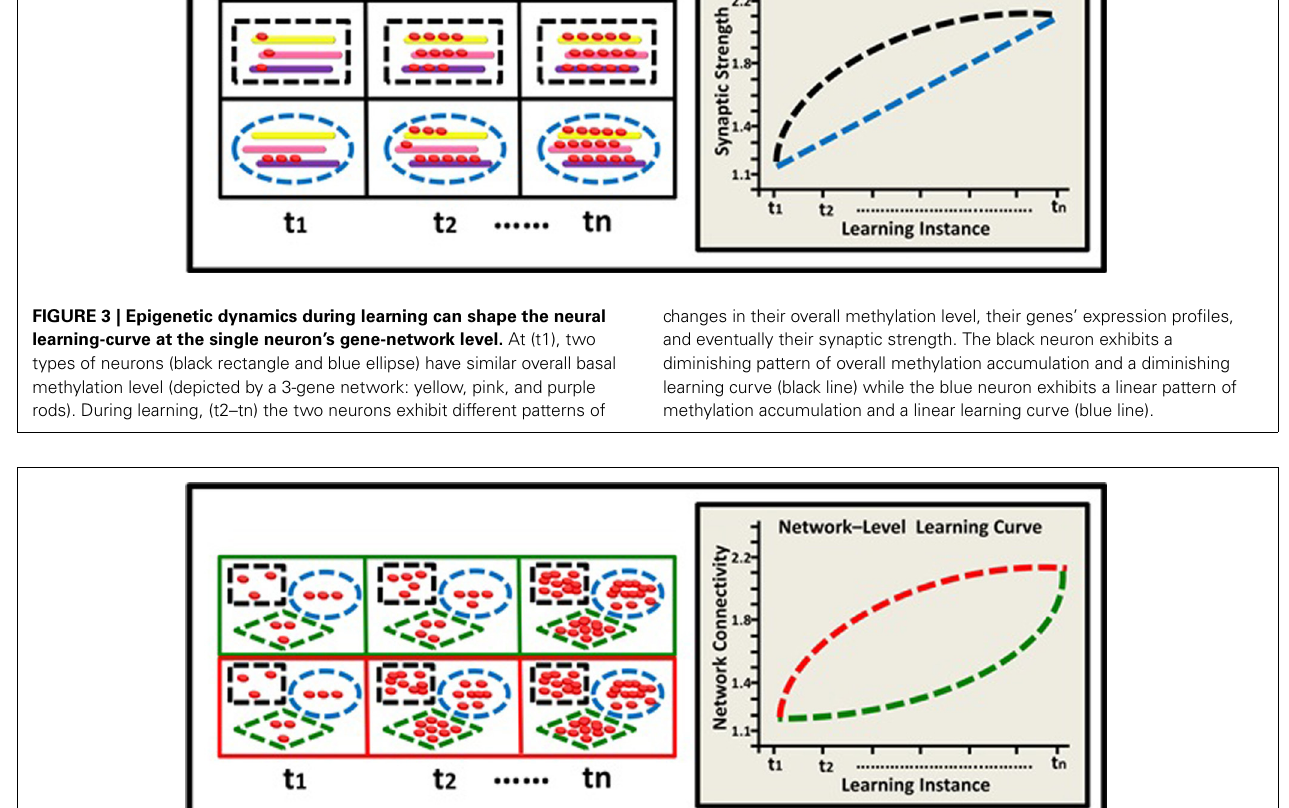
FIGURE 4 | Epigenetic dynamics during learning can shape the neural learning-curve at the neural-network level. Two neural networks (green and red squares) comprised of 3 neurons each (black rectangle, blue ellipse, and green diamond), have similar overall basal methylation level at (t1). During learning, (t2–tn) these two networks exhibit different patterns of